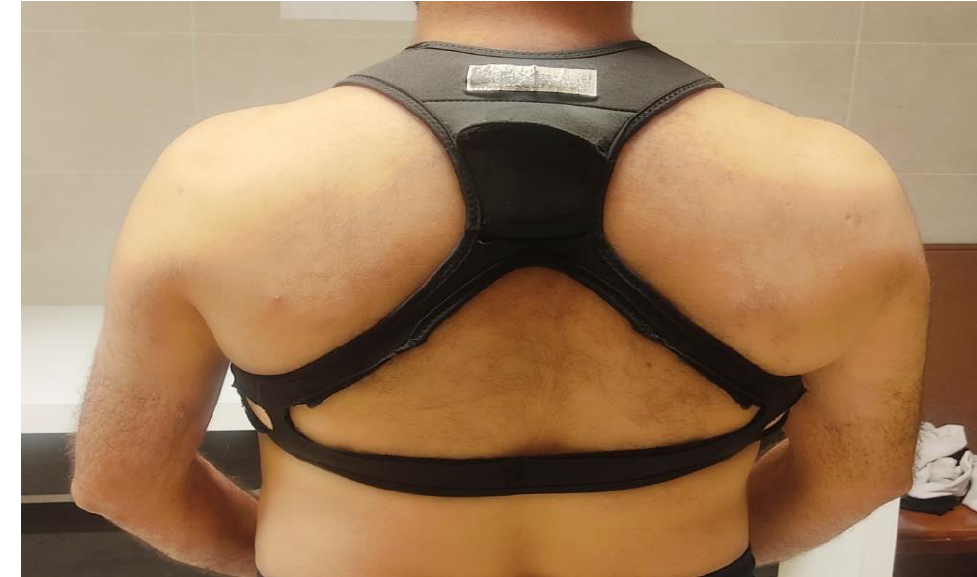
Figure 2. Describes the situations in which the sensors are connected to the player body.